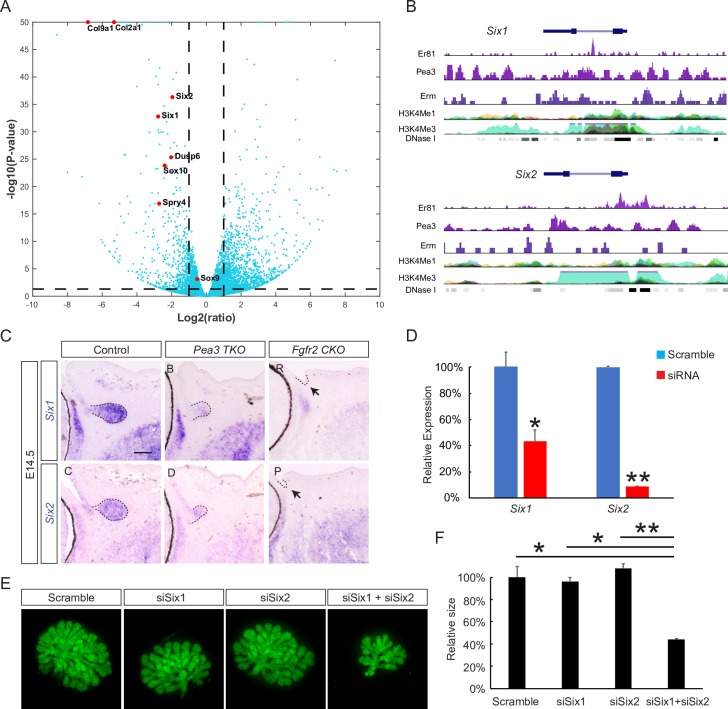
Six1 and 2 are downstream targets of Pea3.(A) Volcano plot of dysregulated genes in Pea3 mutant lacrimal gland buds. Red dots highlight Six1, Six2 and other known targets of FGF signaling down regulated in Pea3 mutants. (B) Pea3 binding sites were presented in the Six1 and Six2 loci as shown by analysis of ChIP-seq datasets. (C) Both Six1 and 2 were downregulated in Pea3 and Fgfr2 mutants. Scale bar, 50μm. (D) Quantitative-PCR demonstrated that siRNA reduced the expressions of Six1 and Six2. Student’s t test, *P<0.01, **P<0.0001, n = 3. (E-F) siRNA knockdown of Six1 and Six2 synergistically disrupted lacrimal gland development in explant lacrimal gland cultures (Mean lacrimal gland sizes relative to control + s.e.m. are shown. One-way ANOVA test, *P<0.05, **P<0.02, n = 3 for each condition).